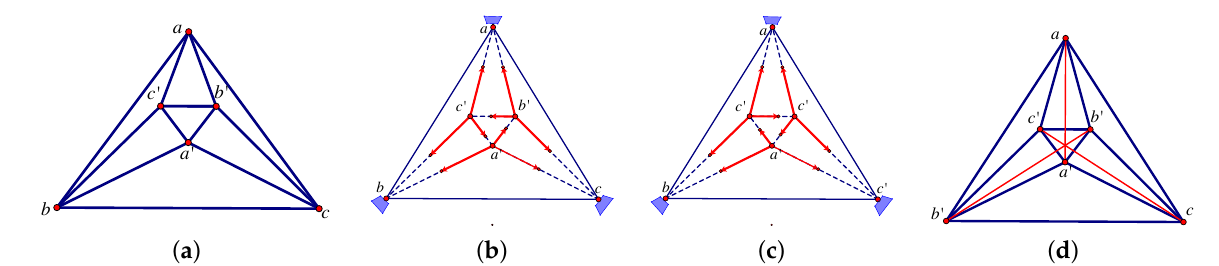
Figure 68. The Morgan Scott split (an octahedral graph) ( a ), with the two 3-directed orientations ( b , c ) and the projective condition for dependence ( d ).